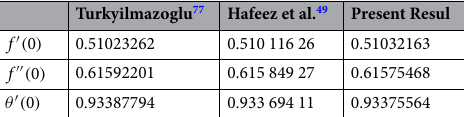
Table 3. Comparison of f ′ ( 0 ) , f ′′ ( 0 ) and θ ′ ( 0 ) for Pr = 6.2, β = β 1 = β 2 = 0, (cid:31)